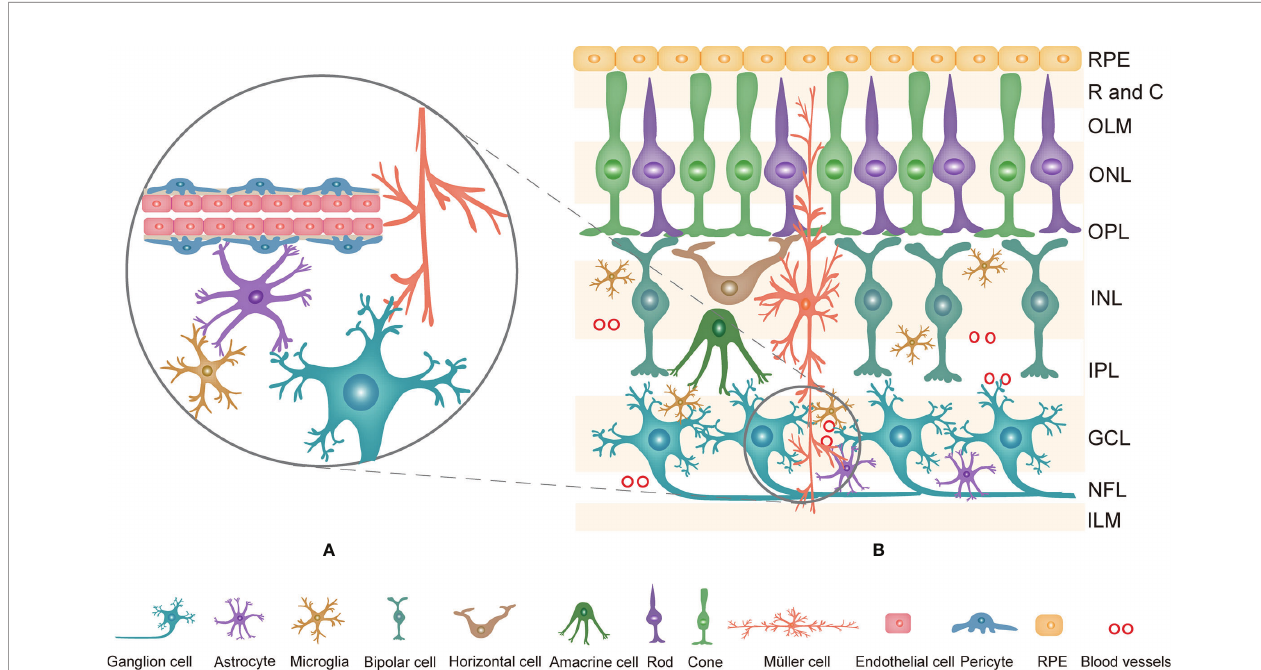
FIGURE 1 | (A) The composition of the retinal NVU. Neurons, Müller cells, astrocytes, microglia, endothelial cells and pericytes are linked together to form the retinal NVU. (B) Structure of the retina and the distribution of retinal NVU components in the retina. The retina is generally divided into ten layers. Retinal neurons, various glial cells and blood cells are distributed in the corresponding layers in the retina. NVU, neurovascular unit; RPE, Retinal pigment epithelial; R and C, rod and cone; OLM, outer limited membrane; ONL, outer nuclear layer; OPL, outer plexiform layer; INL, internal nuclear layer; IPL, internal plexiform layer; GCL, ganglion cell layer; NFL, nerve fi ber layer; ILM, internal limited